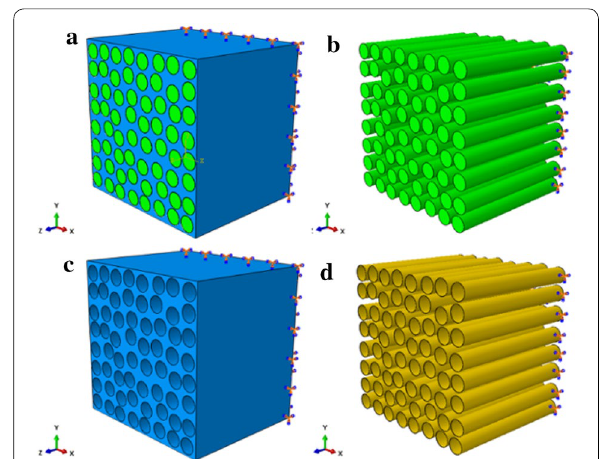
Figure 4 Geometry model of carbon fiber/cyanate ester